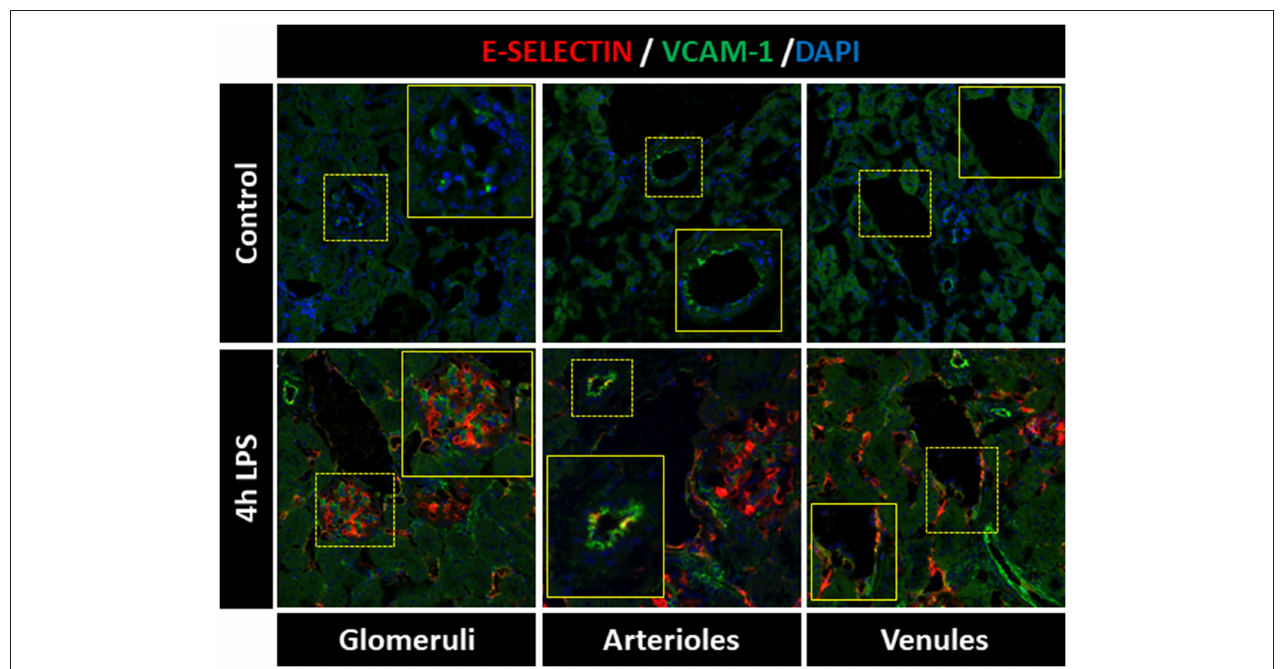
FIGURE 1 | Distinct expression patterns of E-selectin and VCAM-1 are found within kidney microvascular compartments of LPS-treated mice. E-selectin and VCAM-1 expression varied between and within the renal microvascular segments of LPS-treated mice. The images show immunofluorescence staining of E-selectin (red), VCAM-1 (green), and DAPI nuclear staining (blue) in the kidney of control mice (vehicle treated) and mice challenged with LPS (1 mg/kg, i.p.) and sacrificed 4h later. All images were captured with equal exposure times. Original magnification